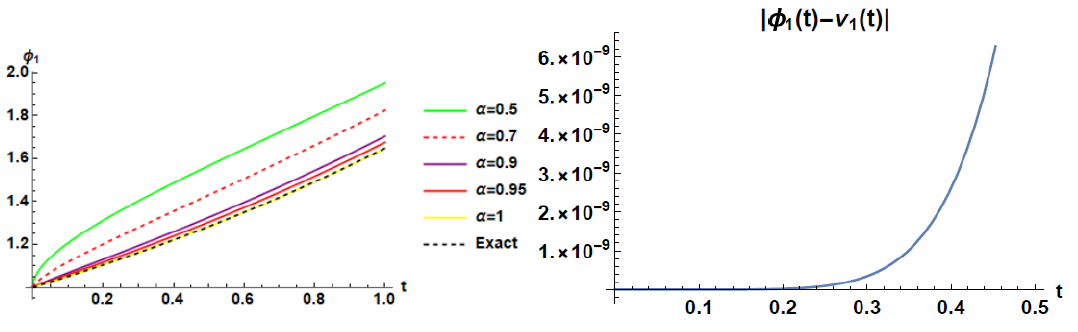
Figure 1: Exact, profile approximate solutions and absolute error regarding ν 1 of Example 1.